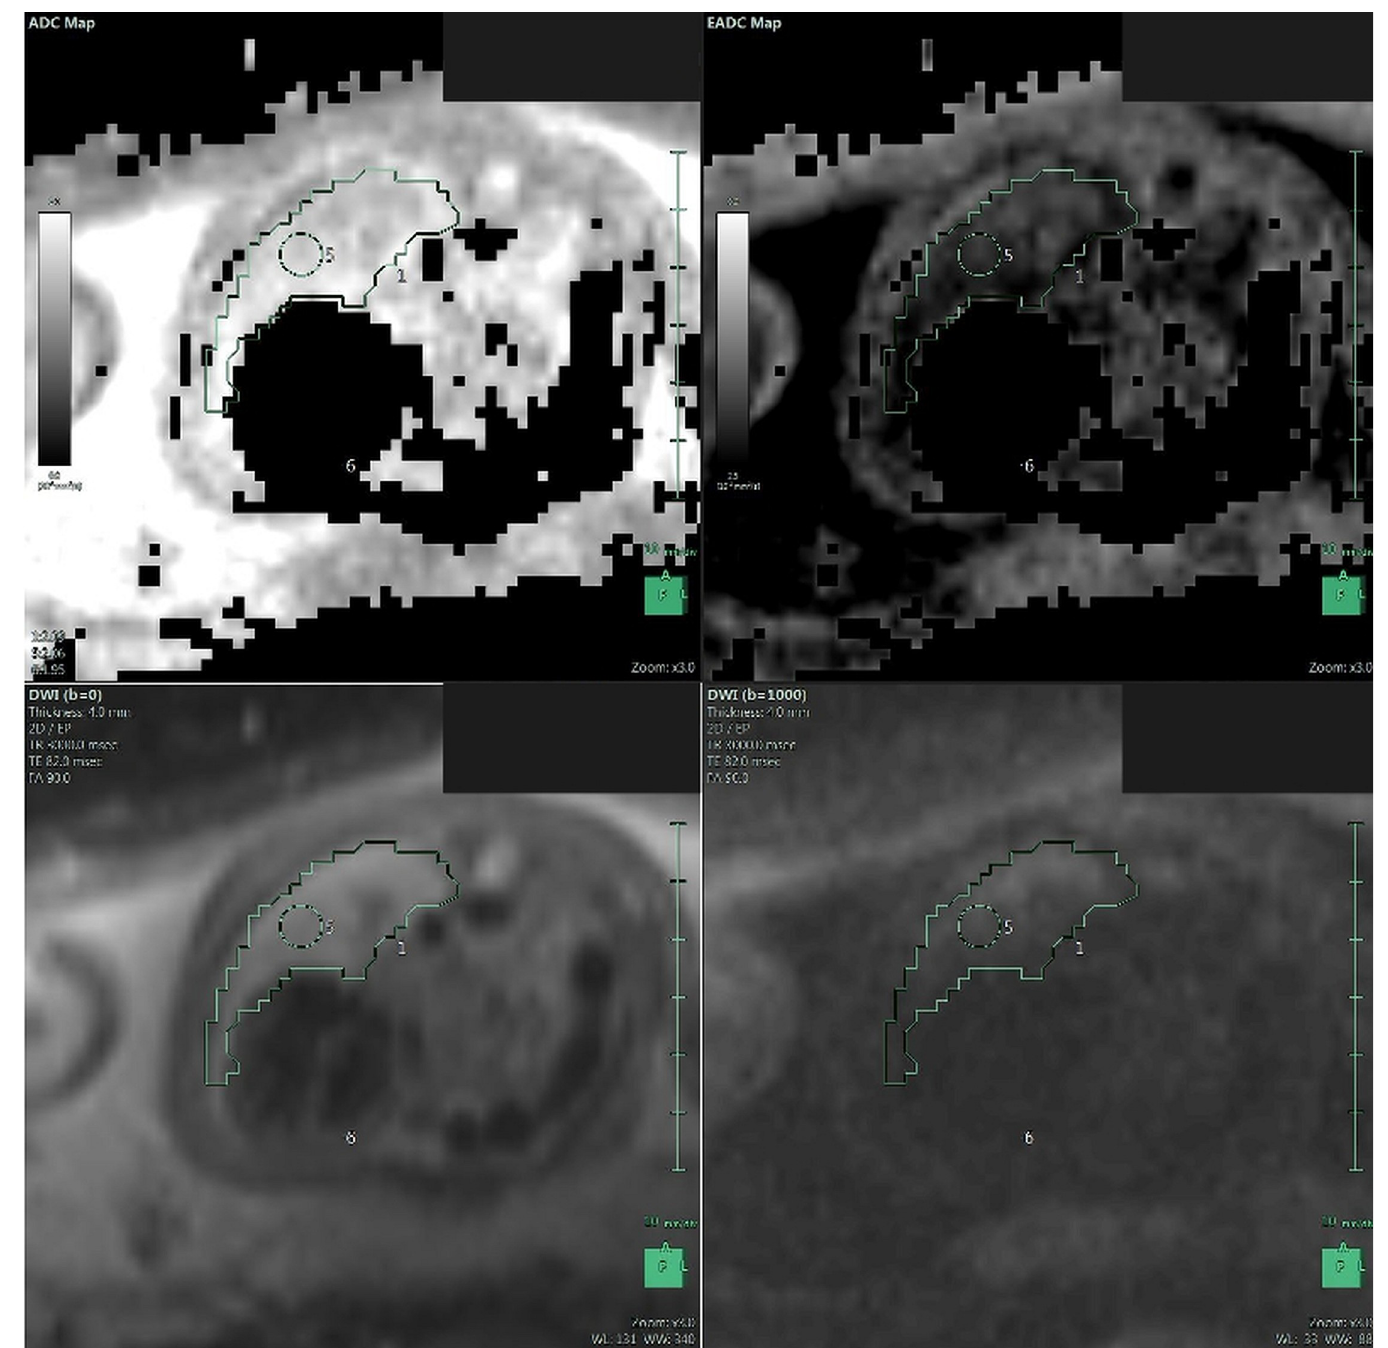
Fig 6. Apparent diffusion coefficient. MRI calculation of the apparent diffusion coefficient (ADC) on diffusion-weighted sequences.